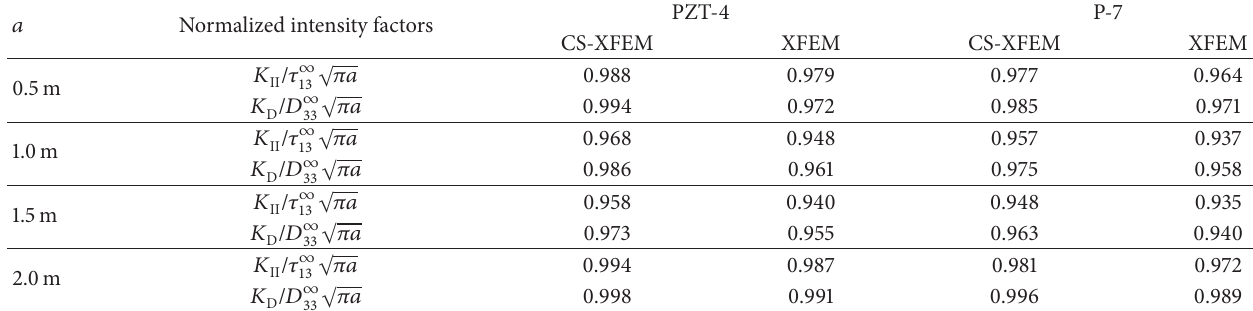
Table 5: Normalized intensity factors under different crack lengths for electromechanical Griffith crack (shear load). 𝑎 Normalized intensity factors